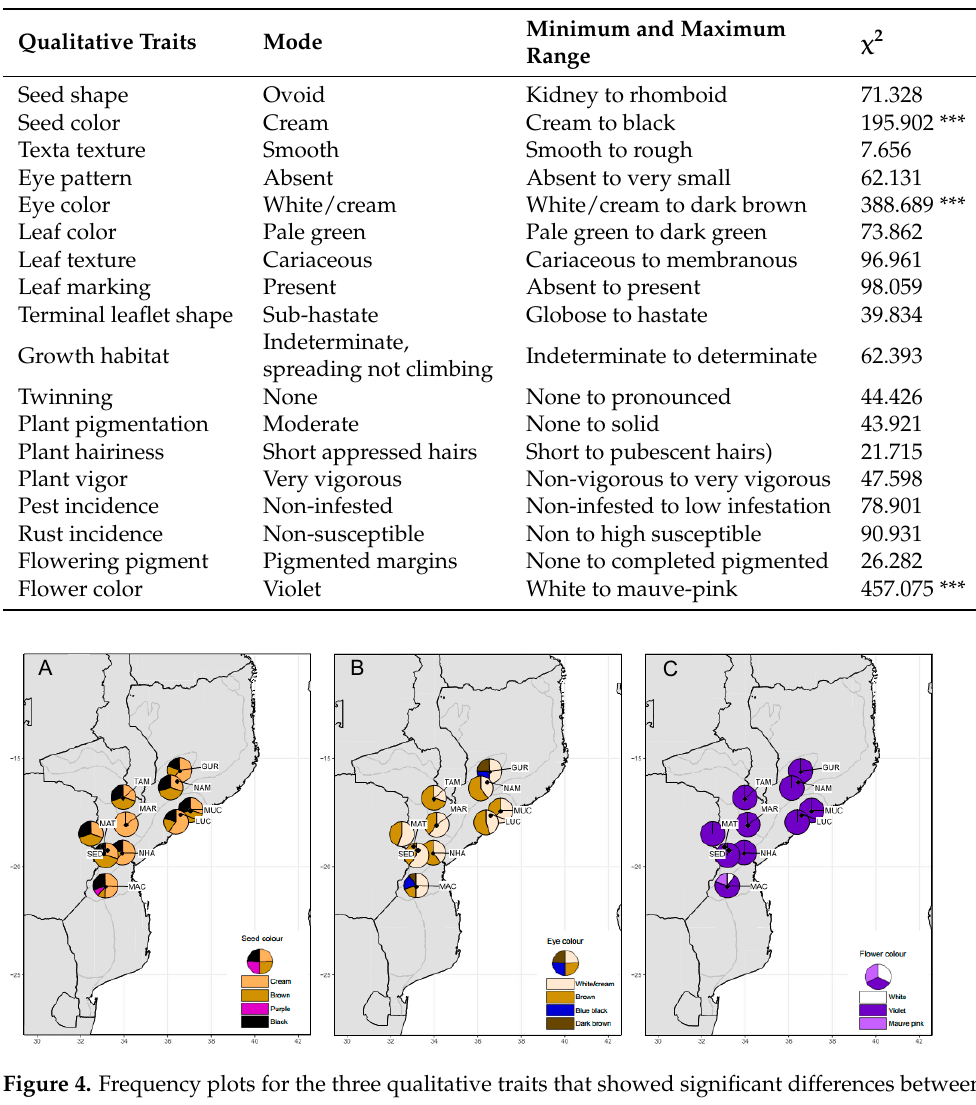
Figure 4. Frequency plots for the three qualitative traits that showed significant differences between the landraces of Vigna unguiculata : seed color ( A ), eye color ( B ) and flower color ( C ). Names of landraces follow Table 1. A PCA with all morphological traits explained 39.18% of the total variance among the 610 cowpea specimens, using an eigenvalue greater than one as the measure of signif- icance of a principal component (Figure 5). No strong spatial clustering was found in the PCA plot except for MAR and MUC. The two cultivars were clustered within cowpea accessions collected in the landraces.